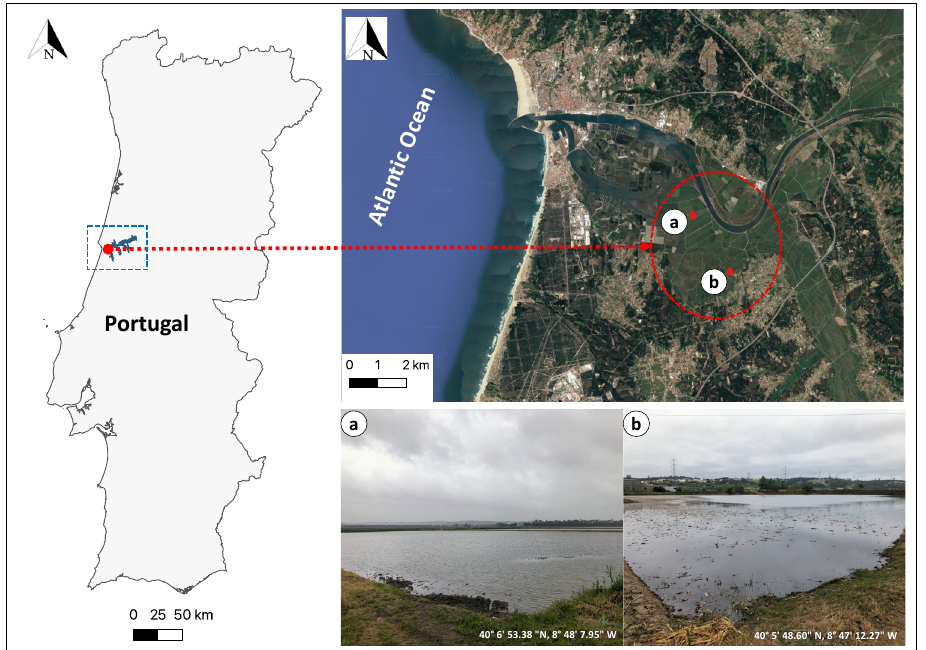
Figure 1. Location map of the selected rice field plots inserted in the Lower Mondego Irrigation District (LMID; blue area), in Portugal: ( a ) Quinta do Canal and ( b ) Pranto (adapted from Google Earth 2021).